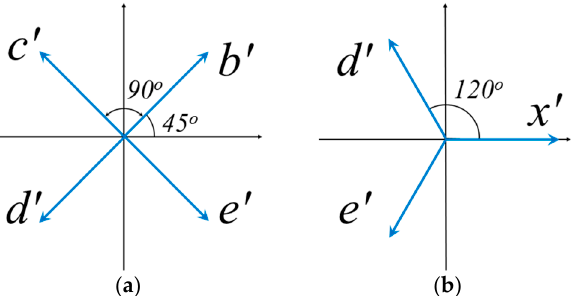
Figure 6. Configuration of the proposed vector space diagrams: ( a ) one-phase fault; ( b ) two-phase fault.